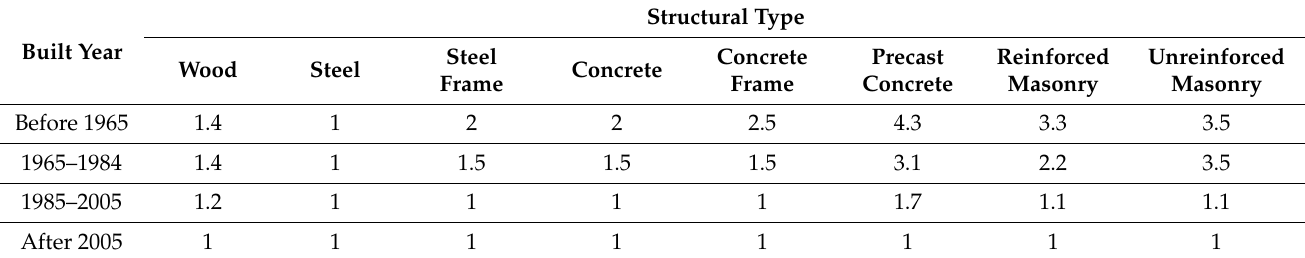
Table 3. Matrix used to determine criterion B (adapted from NRC1992, NBCC2005, and FEMA-154).